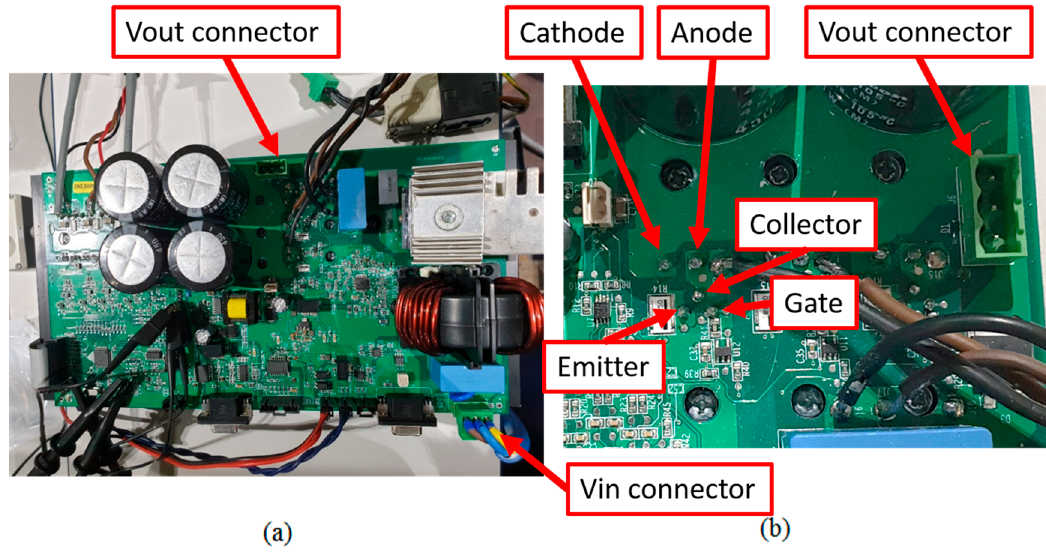
Figure 10. ( a ) PCB surface; ( b ) Contact points accessible from the Automatic Test Equipment (ATE).